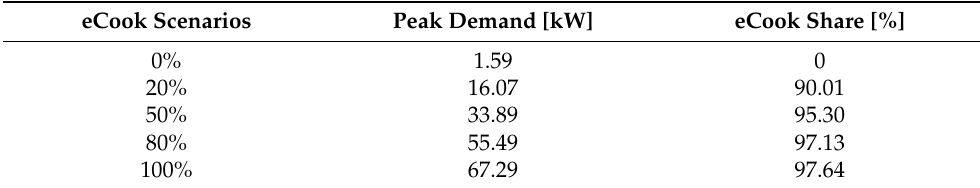
Figure 5. Aggregated HH load profiles (eCook + non-eCook load) for different eCook penetrations. Table 1. eCook contribution with respect to the peak